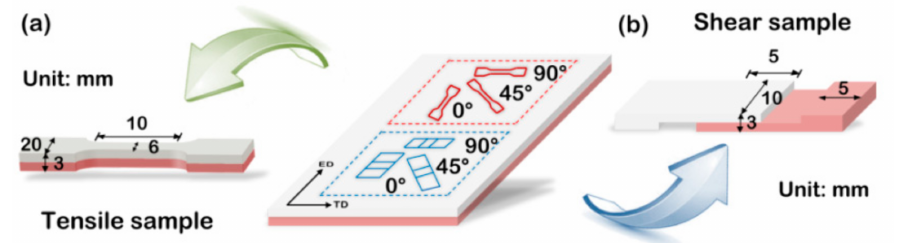
Figure 2. Schematic diagrams of tensile sample ( a ) and shear sample ( b ) in W3/L5 laminated